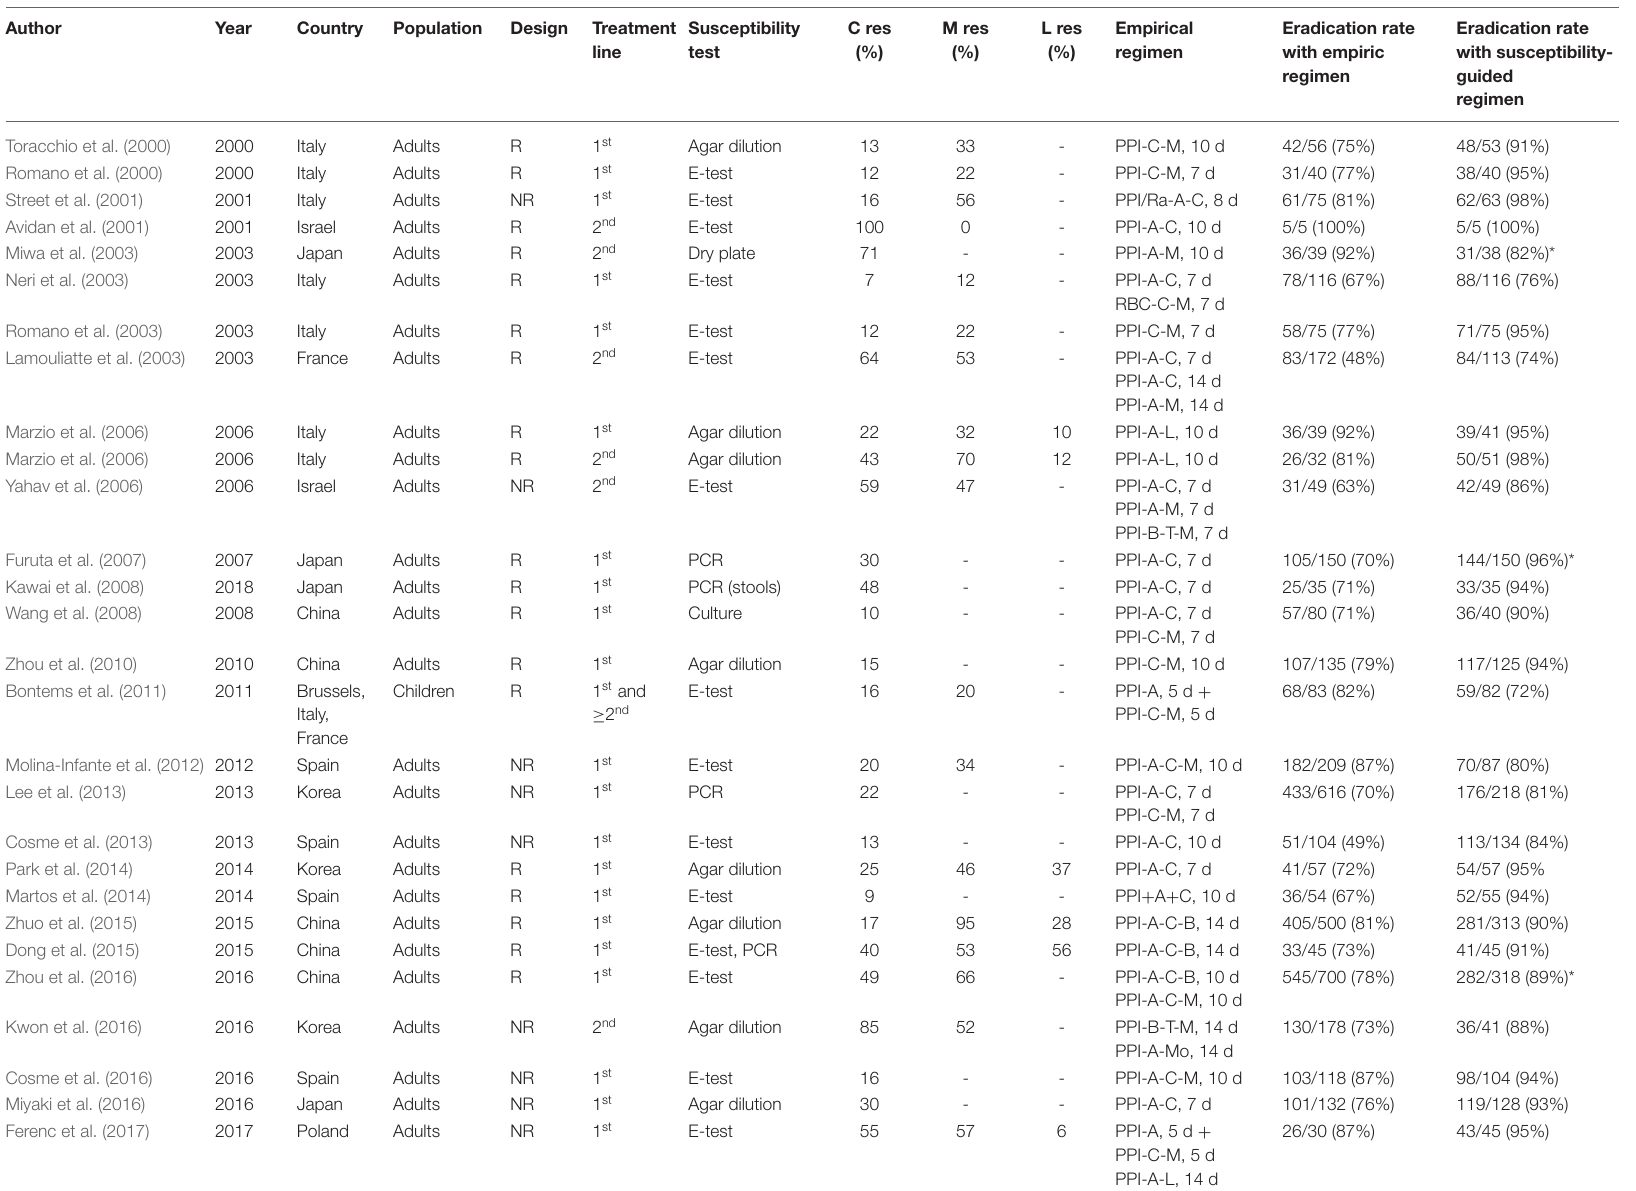
TABLE 1 | Characteristics of studies comparing empirical vs. susceptibility-guided treatment for H. pylori